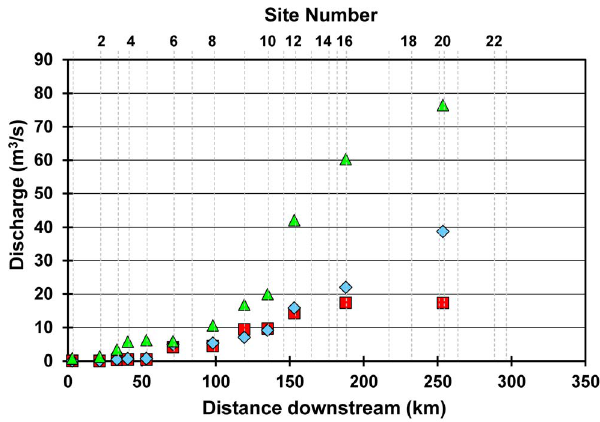
Figure 3. Grand River discharge. Daily mean discharge for the Grand River at gauged sites for each sampling date; Jun 2007 (blue